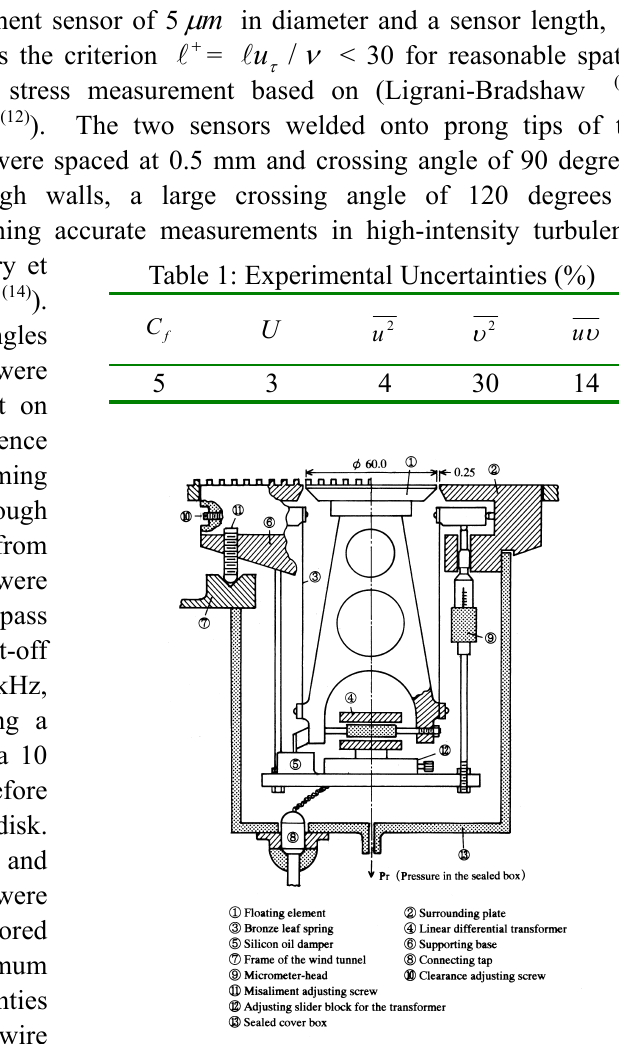
Fig.2 Direct measurement device for the wall shear